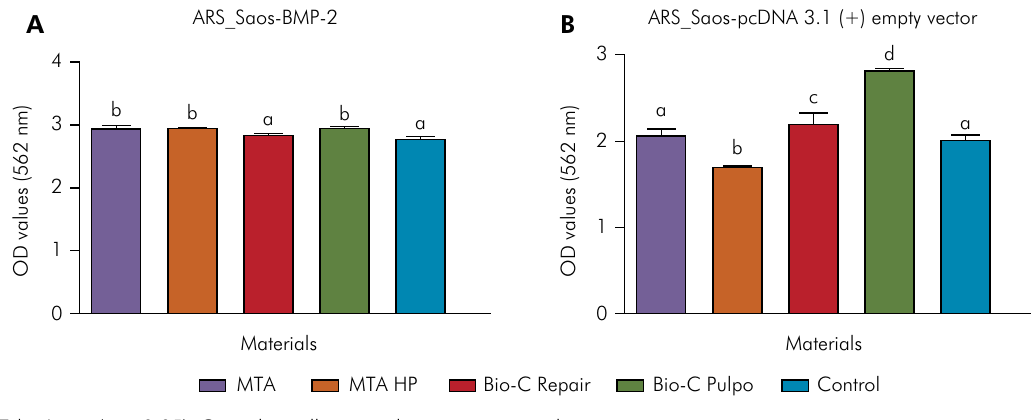
Figure 4. ARS statistical analysis after 21 days of exposure of the materials (MTA, MTA HP, Bio-C Repair, Bio-C Pulpo at 1:12 dilution) to (a) Saos-BMP-2 transfected cells and (b) Saos-pcDNA 3.1 (+) empty vector. Unexposed cells were the control group. Identical triplicates were prepared for each reaction, and the experiment was repeated three times independently (n = 3/group). Bars with different letters represent significant differences among the